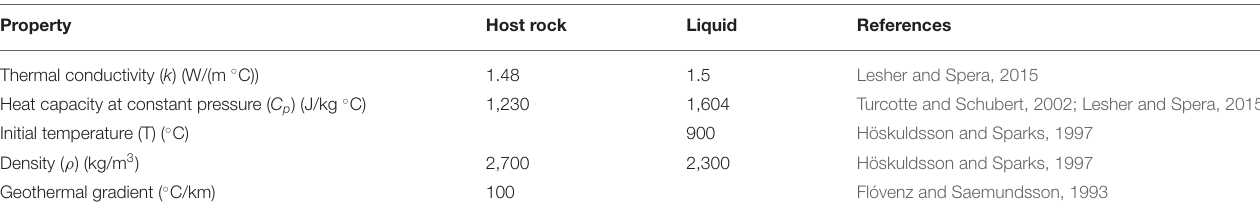
TABLE 1 | Thermal properties used for cooling